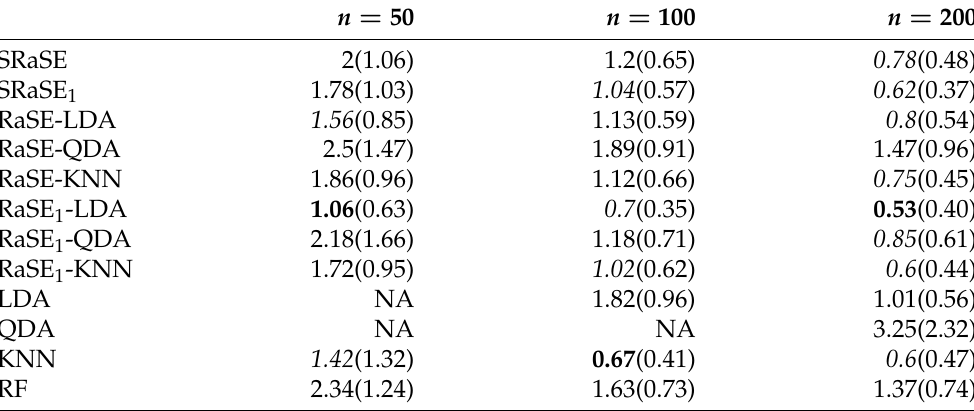
Table 5. Summary of test classification error rates for each classifier under various sample sizes over 200 repetitions for the hand-written digits recognition data set. The results are presented as mean values with the standard deviation values in parentheses. Here, the best performing method in each column is highlighted in bold and the methods that are within one standard deviation away are highlighted in